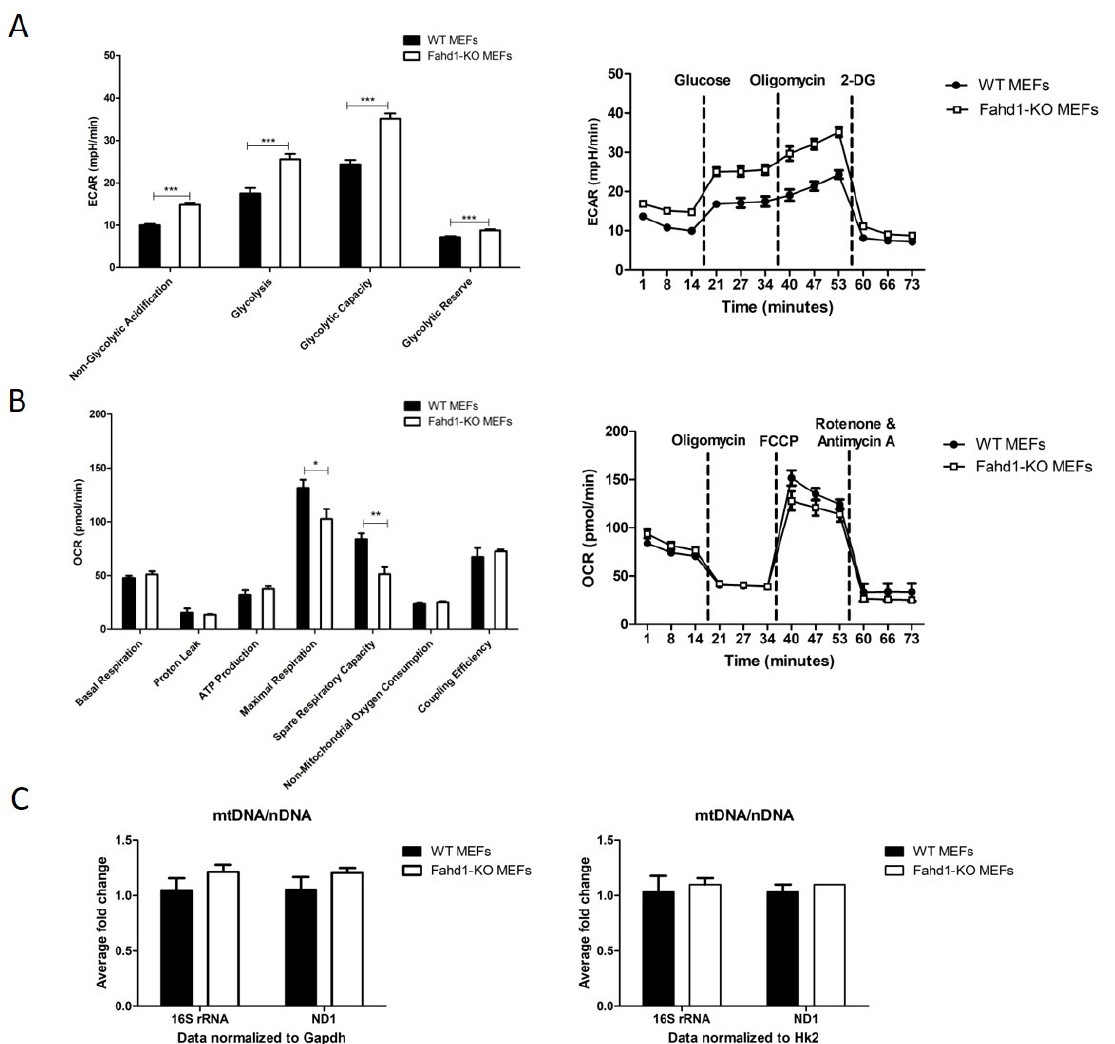
Figure 3. Increased glycolysis in Fahd1-KO MEFs. ( A ) ECAR measurements in mpH/min/cell using Seahorse XFp analyzer and following glycolysis stress test protocol showed a highly significant increase in basal glycolysis, glycolytic capacity, non-glycolytic acidification, and glycolytic reserve in Fahd1-KO MEFs as compared to WT, *** p < 0.001, n = 6. ( B ) OCR measurements in pmol/min/cell using Seahorse XFp analyzer and following MitoStress test protocol showed a trend to decreased OCR in Fahd1-KO vs. WT MEFs, whereas maximal respiration and spare respiratory capacity parameters were significantly decreased in Fahd1-KO, * p < 0.05, ** p < 0.01, n = 3. ( C ) Average fold-change of mtDNA/nDNA ratio showing the expression of the mt genes 16S rRNA and ND1 as normalized to two housekeeping genes Gapdh and Hk2. The DNA copy number of these genes was determined in WT and Fahd1-KO MEFs. No significant difference was observed, n = 6. MEFs: mouse embryonic fibroblasts, iPSCs: induced pluripotent stem cells, WT: wild type, KO: knock-out, ECAR: extra cellular acidification rate, OCR: oxygen consumption rate, mt: mitochondrial, n: